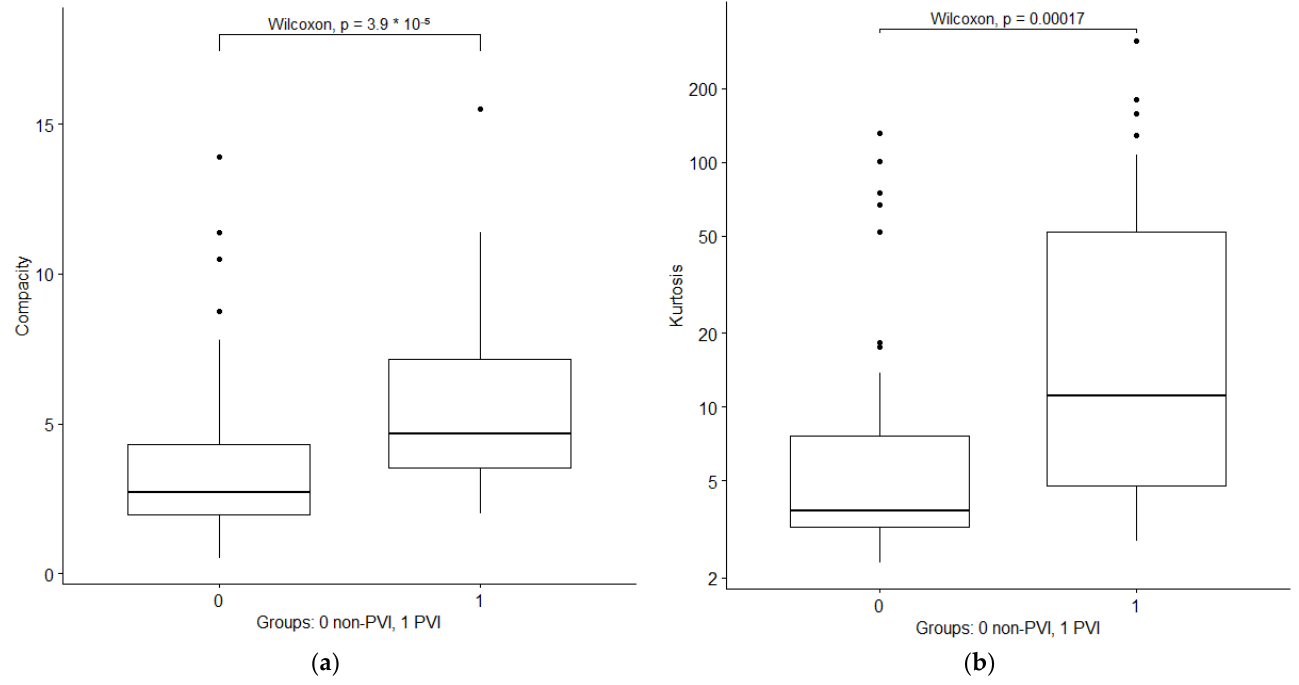
Figure 2. Boxplots of first order radiomics features compacity and kurtosis in portal venous phase in patients without and with PVI development. ( a ) Compacity; ( b ) kurtosis.